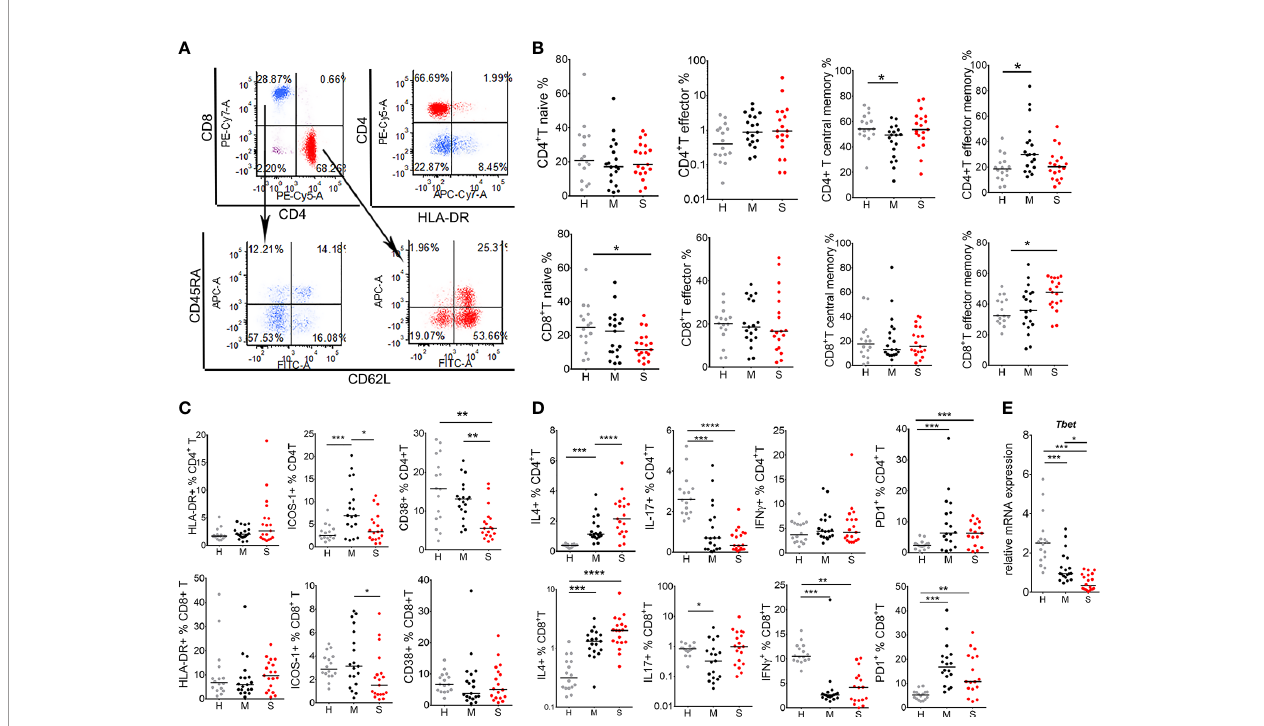
FIGURE 2 | T cell response in coronavirus disease (COVID)-19 patients and healthy donors. (A) Gating strategy for identi fi cation of T cell subsets is shown. After exclusion of doublets, T cells were gated from lymphocytes (CD45 hi SSc low ) region as CD3 + CD56 - cells, followed by CD4 and CD8 phenotyping. (B) The percentages of naïve (CD62L + CD45 + ), effector (CD62L - CD45RA + ), central memory (CD62L + CD45RA - ) and effector memory (CD62L - CD45RA - ) T cells, gated from CD4 + T cell (red) or CD8 + T cell (blue) region as in (A) , are shown as the proportion of total CD4 + or CD8 + T cells. (C) The percentages of HLA-DR + , ICOS-1 + , and CD38 + , and (D) IL-4 + , IL-17 + , IFN- g + and PD1 + CD4 + T, and CD8 + T cells are shown as the proportions of total CD4 + T or CD8 + T cells as indicated. (E) Relative mRNA expression of T-bet in PBMC is shown. (B – E) The results for each donor in the groups of healthy donors (H, n=16), mild (M, n=19) and severe (S, n=19) patients, and the corresponding medians are shown. *p < 0.05, **p < 0.01, ***p < 0.005, ****p < 0.001 as indicated (Kruskal-Wallis test with Dunn ’ s